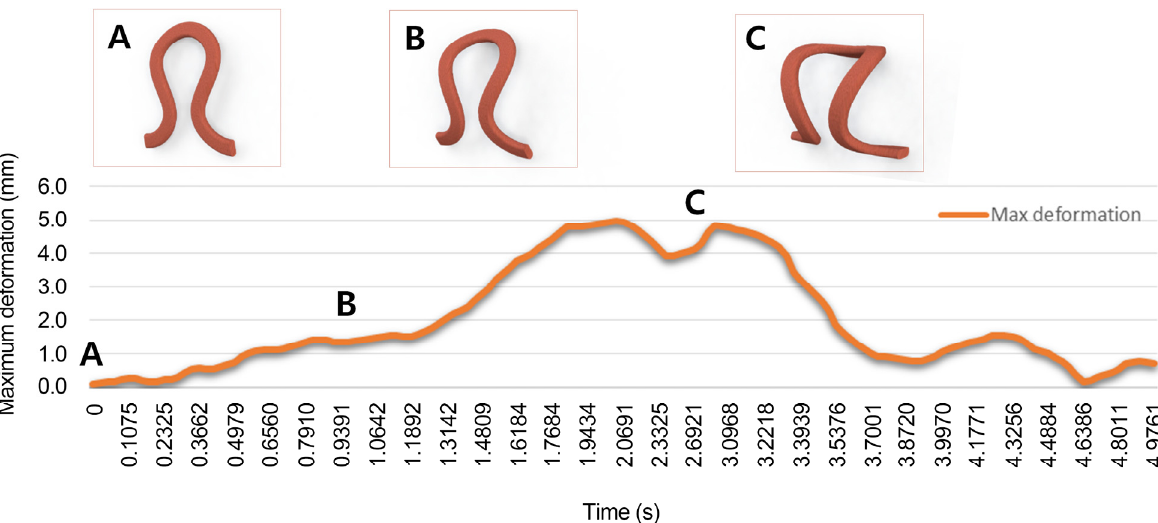
Figure 3. A theoretical modeling with simulation results of a unit loop of SMA wire; generation of a curling motion by increasing the temperature of the knitted wire. A is the original shape of the loop, B is the loop under deformation, and C is the loop at its maximum deformation.